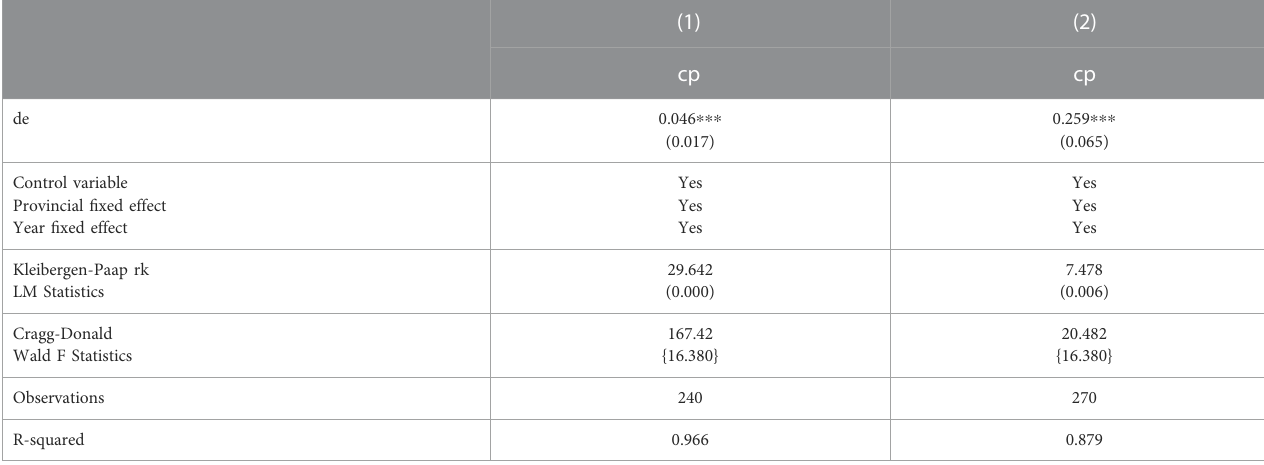
TABLE 8 Two-stage least squares (2SLS) regression.